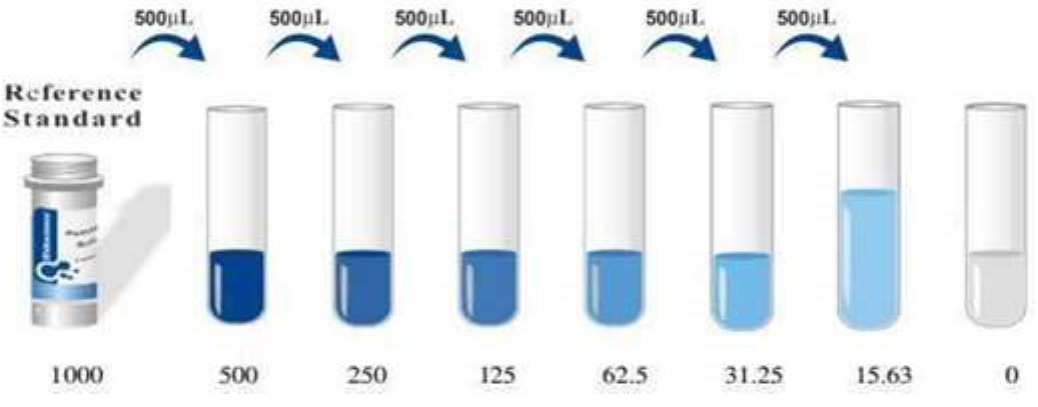
Figure 2: Dilutions of standard